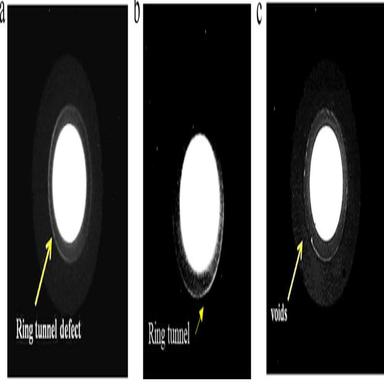
Snap-shot of the Digital Radiography system used for FWTPET inspection.